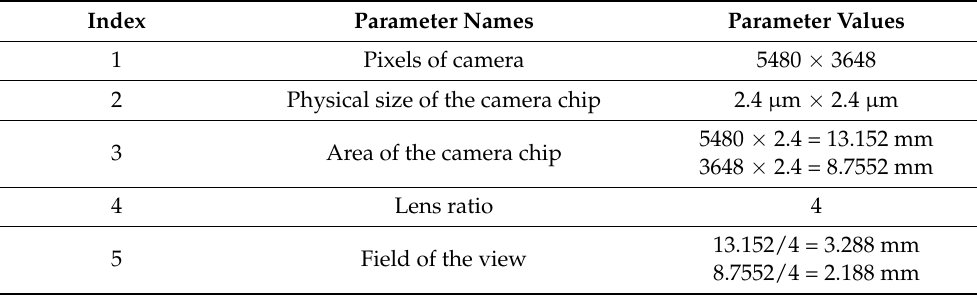
Figure 9. Calibration board.